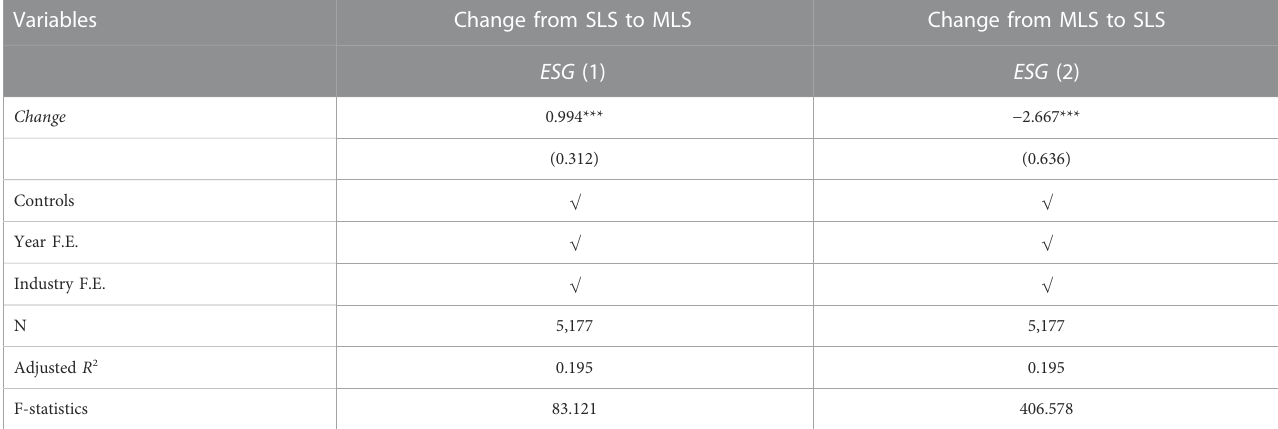
TABLE 4 DID estimation